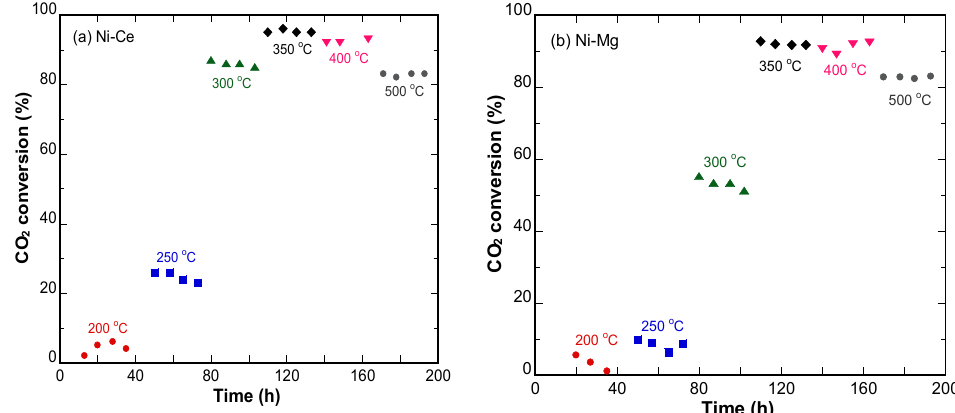
Figure 4. Long-term stability of ( a ) Ni-Mg/Eco and ( b ) Ni-Ce/Eco. ((Flow rate 3.6 cc/min, WHSV = 8700 mL/h/g, 73% H 2 , 18% CO 2 , and 9% Ar).